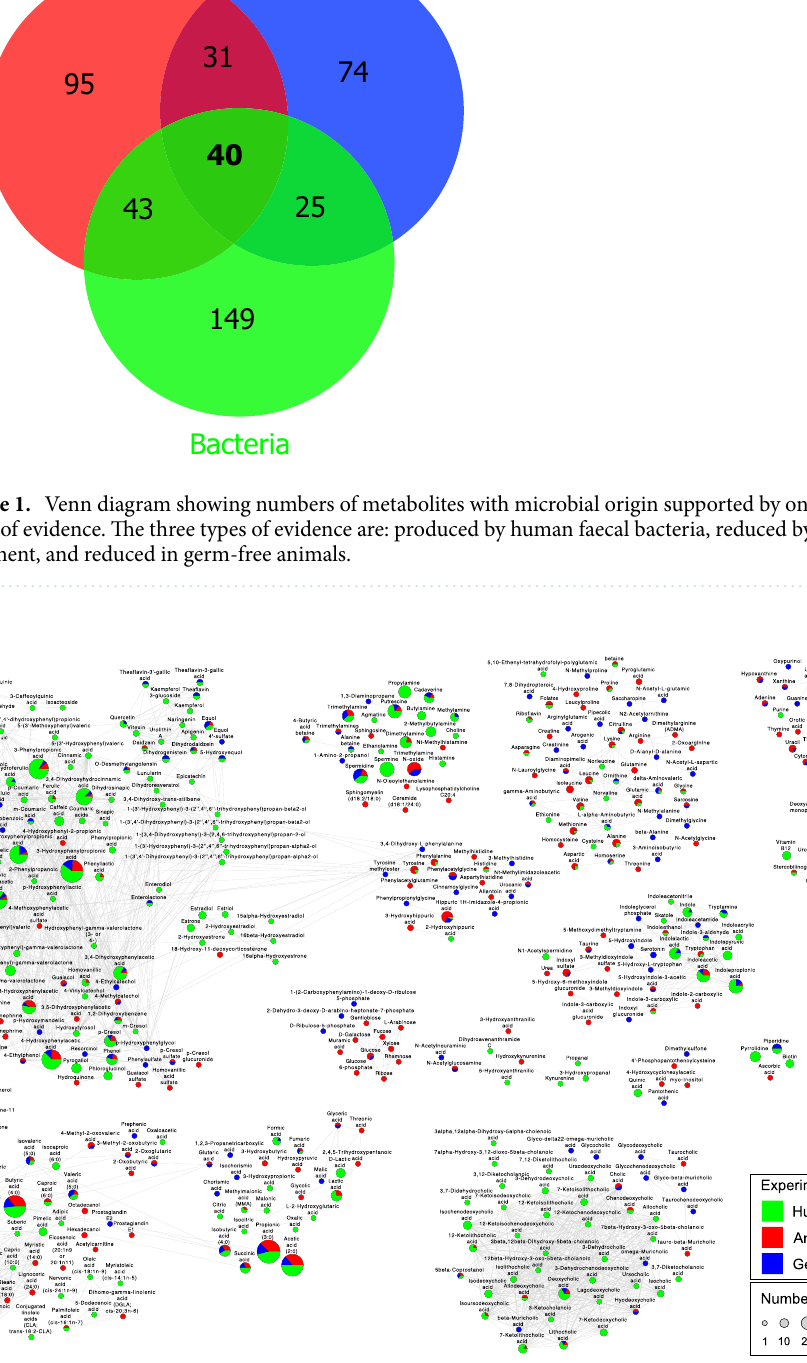
Figure 2. Chemical similarity network of 457 microbial metabolites in the Exposome-Explorer database. Node size is proportional to the number of records supporting their microbial origin. Colours indicate the types of experimental evidence on microbial origin: produced by human faecal bacteria, reduced by antibiotic treatment, and reduced in germ-free